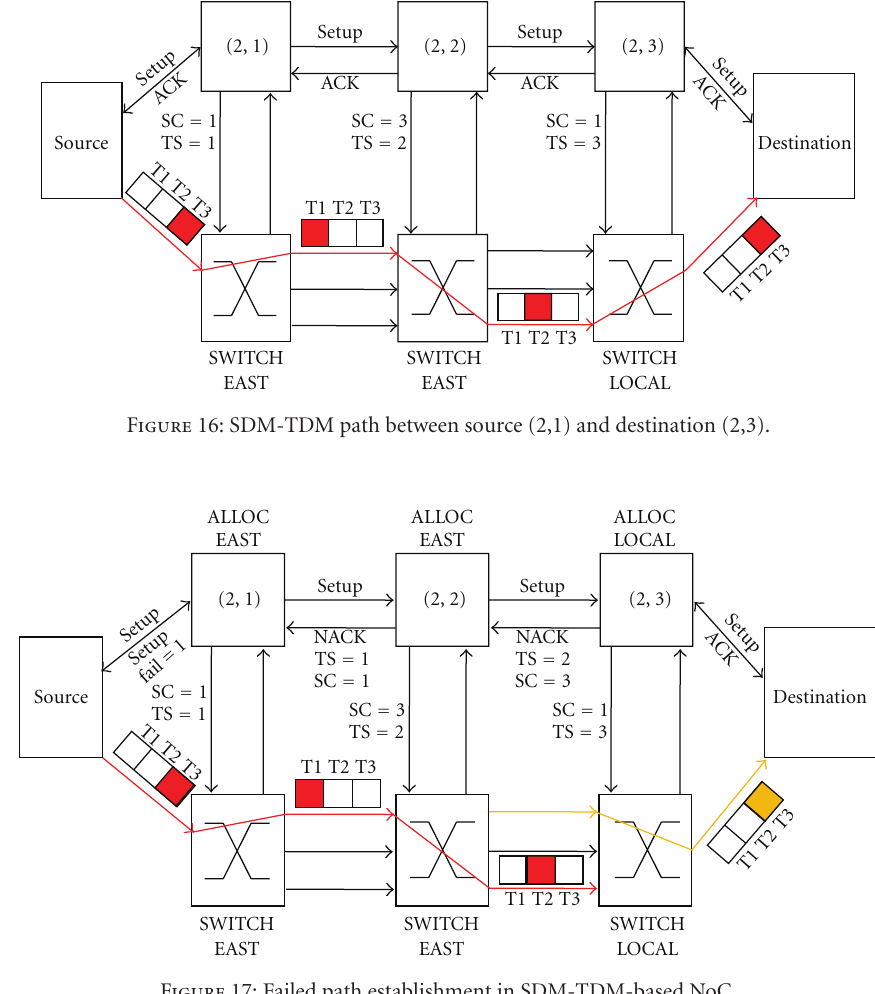
Figure 17: Failed path establishment in SDM-TDM-based